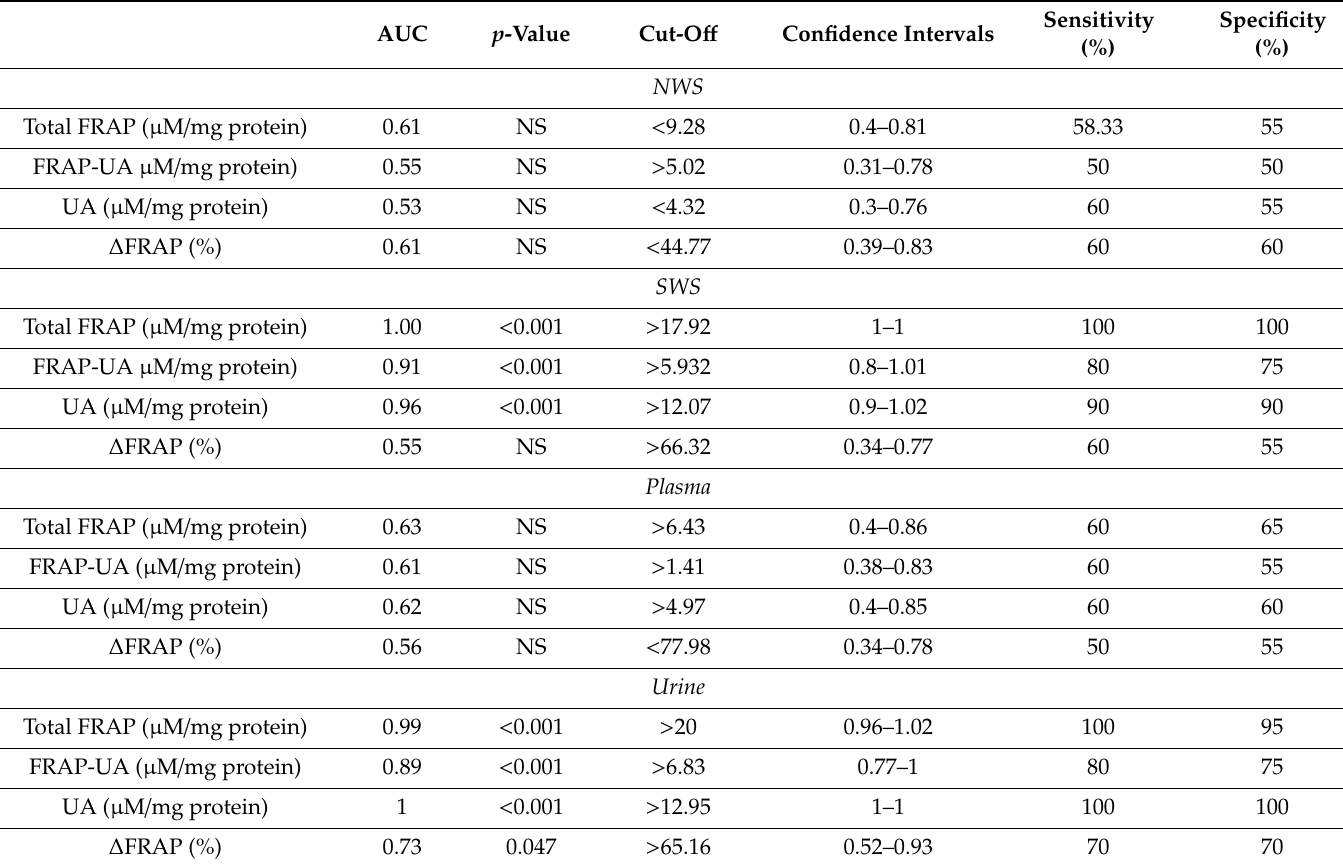
Table 4. Receiver operating characteristic (ROC) analysis of total antioxidant capacity measured by FRAP in saliva, plasma and urine of children with stage 1–3 and 4–5 of chronic kidney disease